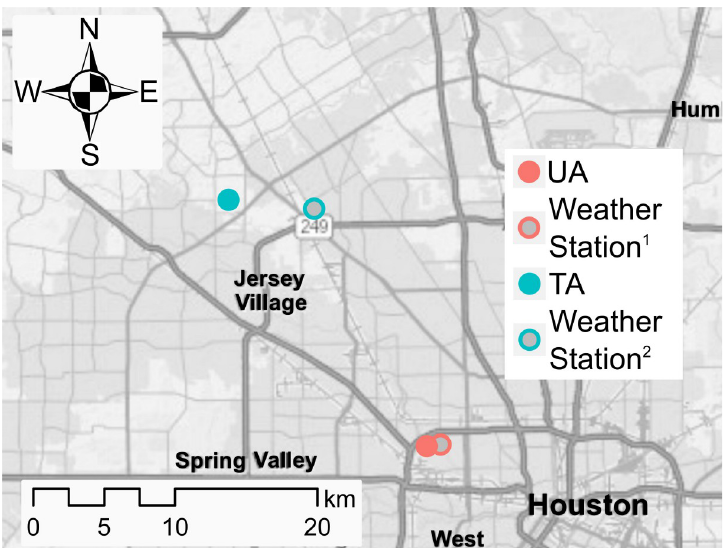
Fig 2. Location of the untreated and treated areas in Harris County, TX, and the closest weather station operated by Harris County Flood Control. Only precipitation data was available from these stations. Map generated with ArcMap [51] contains information from OpenStreetMap and OpenStreetMap Foundation, which is made available under the Open Database